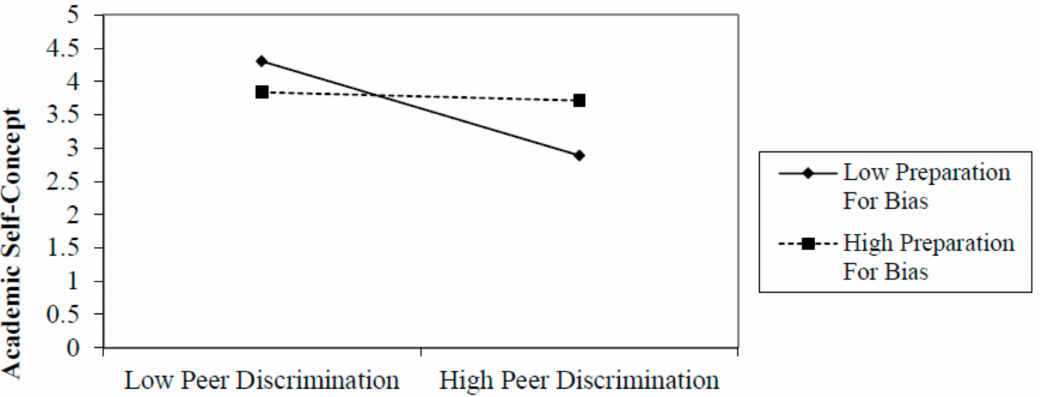
Figure 2. Academic Self-Concept: Moderation–Preparation for Bias.